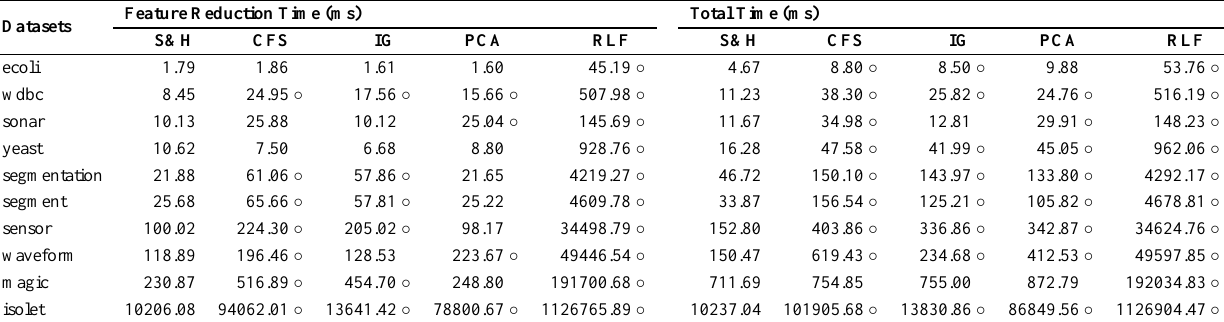
Table 5. Run time comparisons (the less, the better).